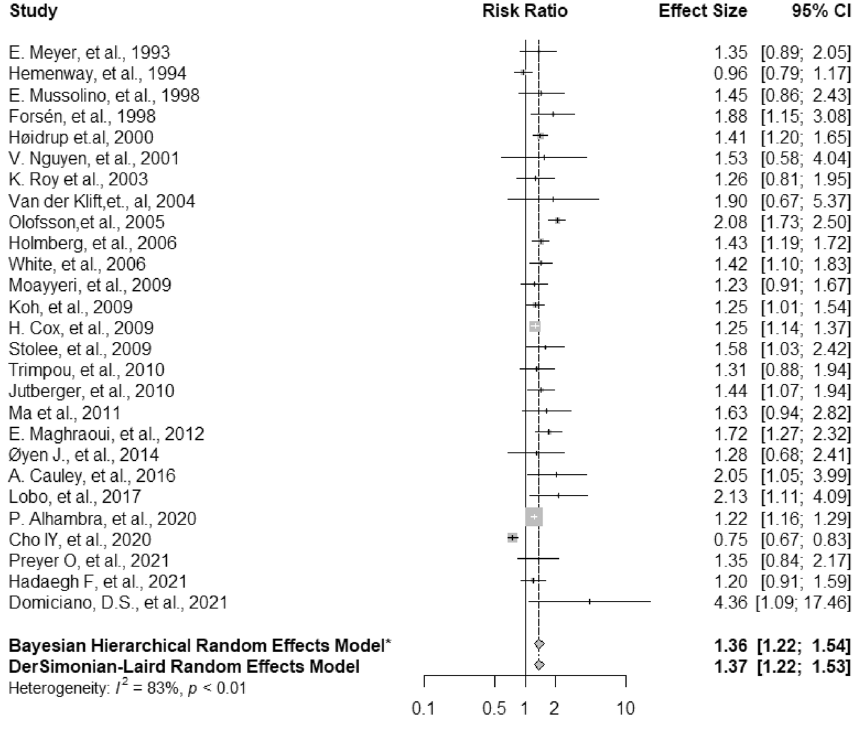
Figure 2. Effects of smoking on the risk of fracture combined, and all eligible studies combined by using frequentist and Bayesian approaches (CI, confidence interval). *In Bayesian Hierarchical Random Effects Model, 95% credible interval is shown.